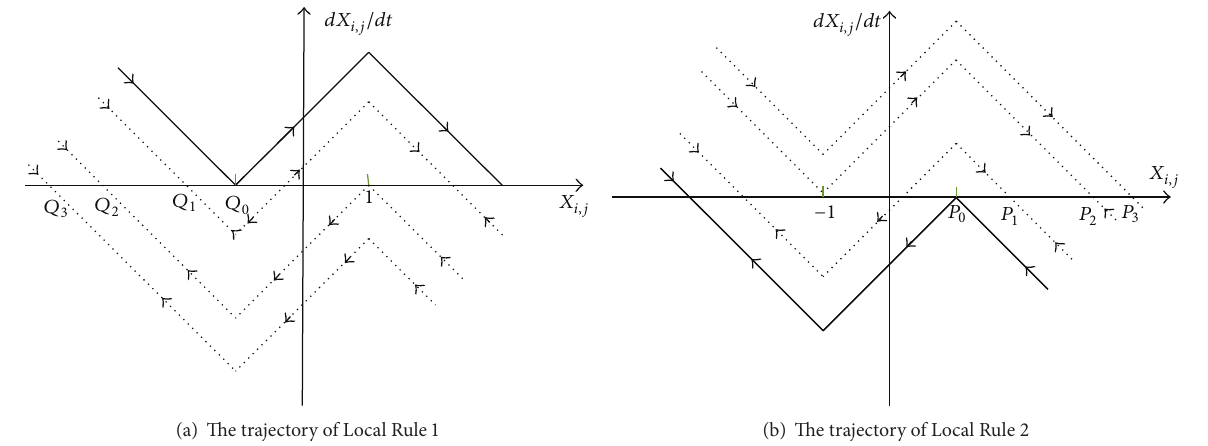
Figure 1: The dynamic trajectory of cell for different local